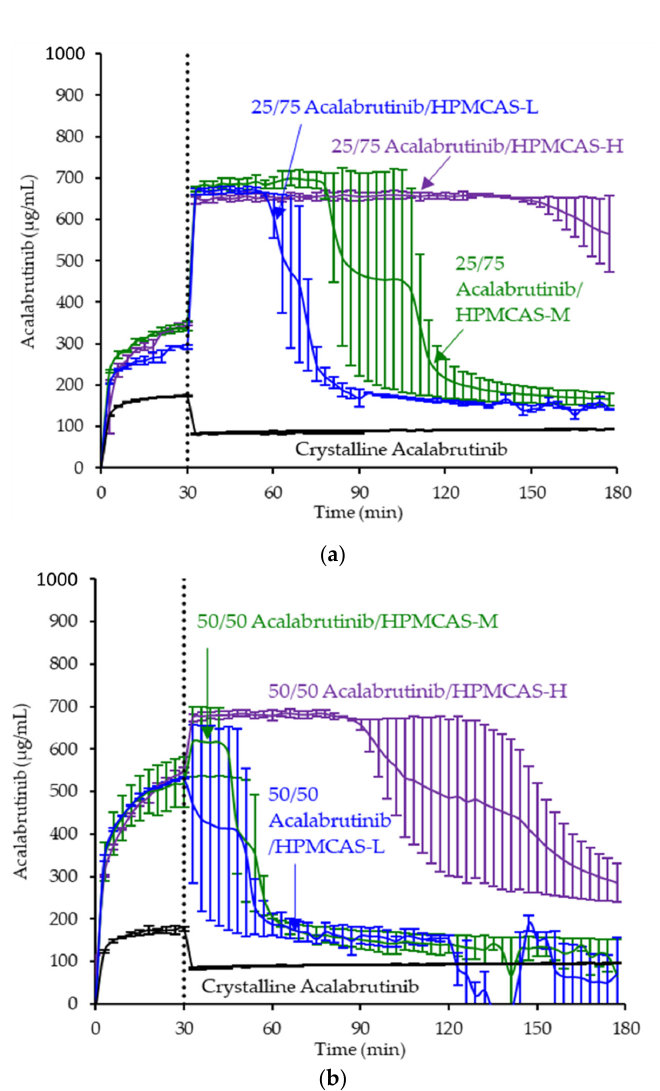
Figure 2. Dissolution profiles of ASD intermediates in a gastric to intestinal transfer dissolution test using a Pion µDiss Profiler under conditions simulating fasted dogs treated with an ARA (gastric pH 5) (curves represent average values whereas error bars represent range, n = 2). Panel ( a ) 25 wt % drug loading ASDs. Panel ( b ) 50 wt % drug loading ASDs.